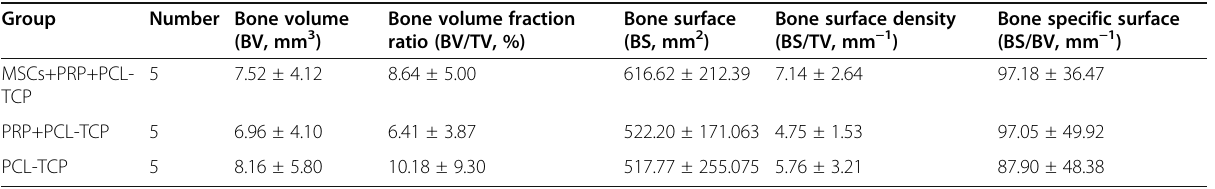
Table 1 Micro-CT bone morphogenic findings Group